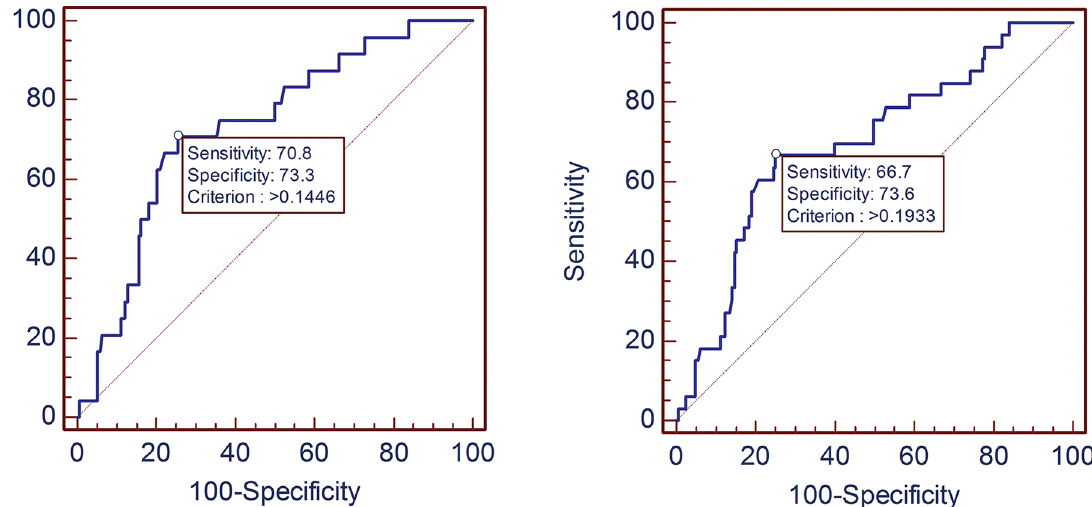
Fig 3. The ROC curve for predicting atherosclerosis burden. The ROC curve for predicting TPS score > 5 in fig 3 (left), the AUC for TPS score > 5 was 0.73 (95%CI 0.66 – 0.79). The ROC curve for predicting SSS score > 5 in fig 3 (right), and the AUC for SSS score > 5 was 0.70 (95%CI 0.63 – 0.76). AUC = area under the curve. ROC = receiver operating